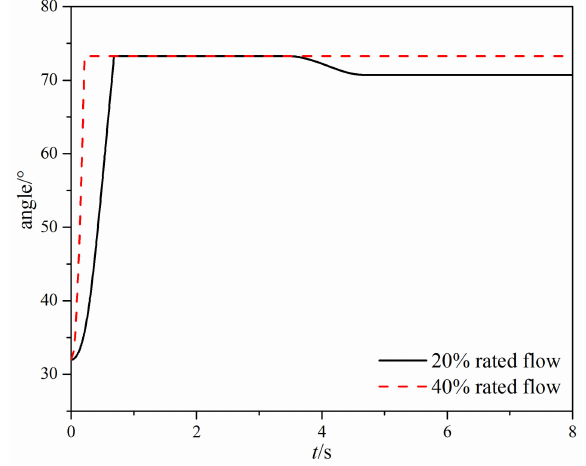
Figure 7. The time-varying opening angle under di ff erent mass flow rates.